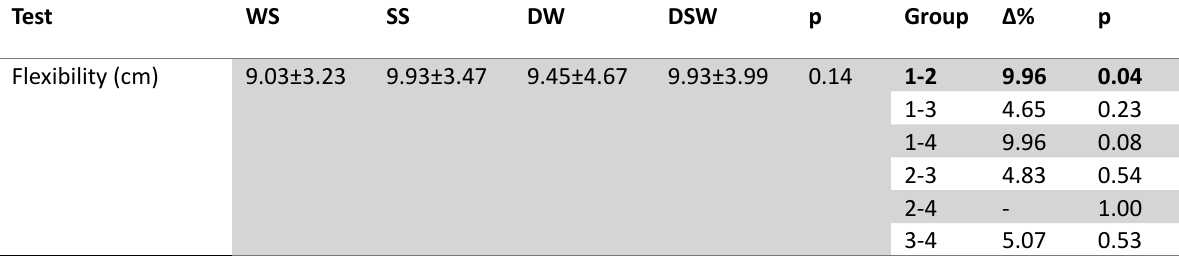
Table 2. Flexibility values and differences after different stretching and warm up protocols Test